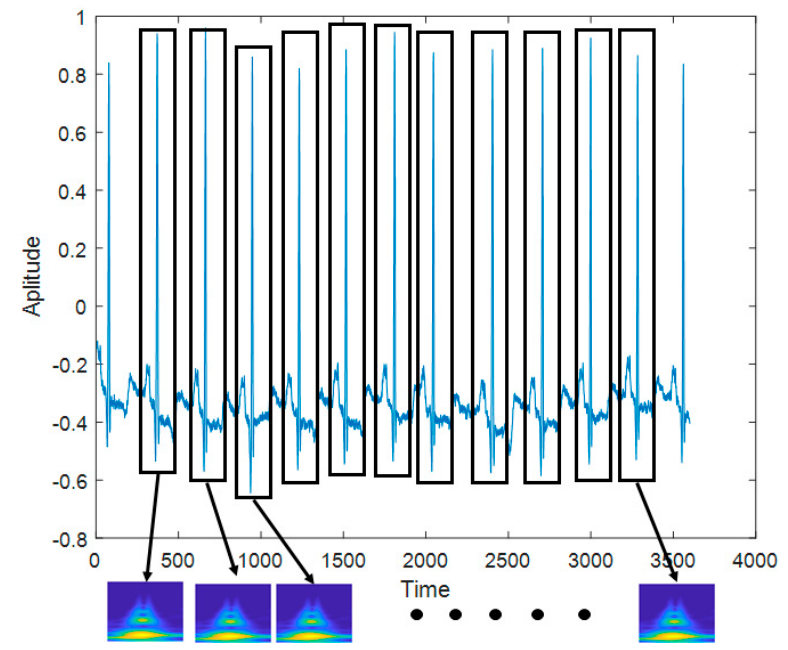
Figure 10. Process of making the input image from the raw ECG signal.